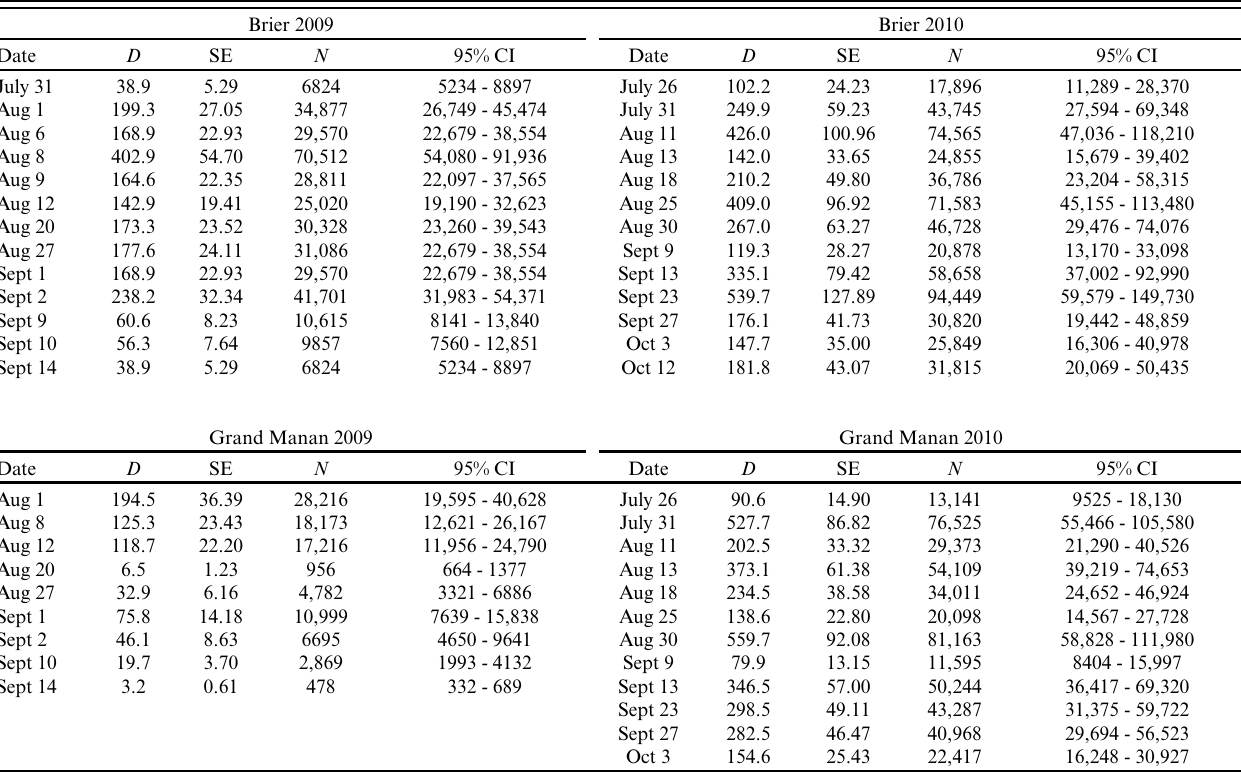
Table 2 . Point estimates for the density (D) and abundance (N) of phalaropes by survey date based on detection models fitted to each of four dataset partitions (region:yr). Density refers to number of phalaropes per square kilometer. Percent coefficient of variation in D and N as estimated by the four models was: 13.58, 23.70, 18.70, 16.45 for Brier 2009, 2010, GM 2009, 2010, respectively. Standard error (SE) for density and confidence intervals (95% CI) for abundance estimates are shown. Inference about the abundance of phalaropes by survey date was restricted to the covered region only: 175 km² in Brier, 145 km² in Grand